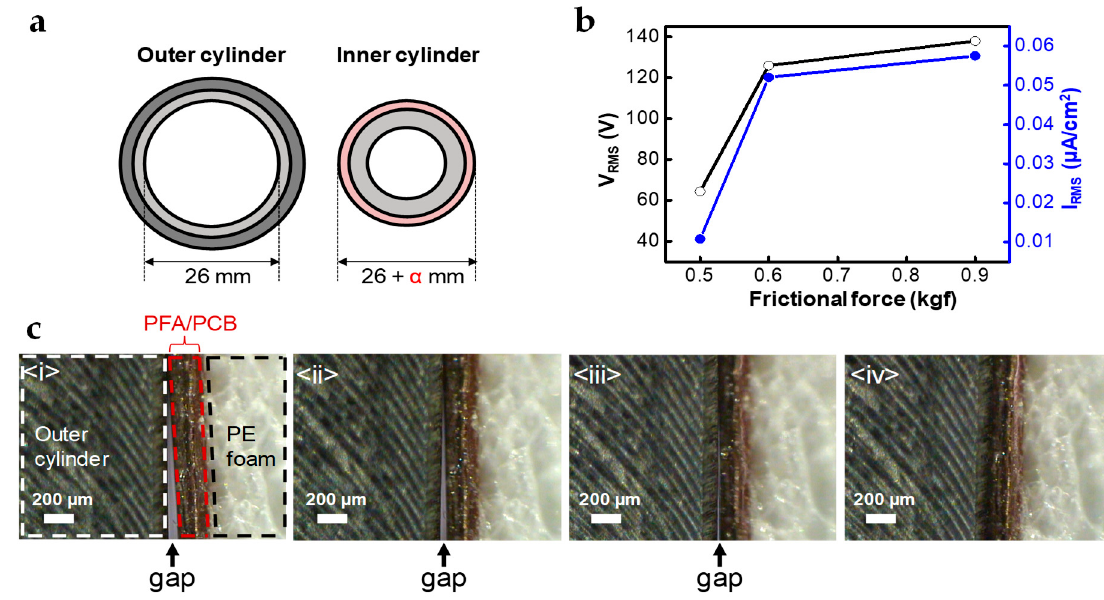
Figure 4. Frictional force as a parameter for output performance of STEG: ( a ) schematic experimental setup to control frictional force through radius control of inner cylinder; ( b ) short-circuit current in RMS value according to increase of frictional force; ( c ) observation by optical microscopy of shape-adapted deformation of PFA film with different α , (i) 0.08 mm, (ii) 0.09 mm, (iii) 0.10 mm, (iv) 0.11 mm, respectively. For α of 0.11 mm, there is no